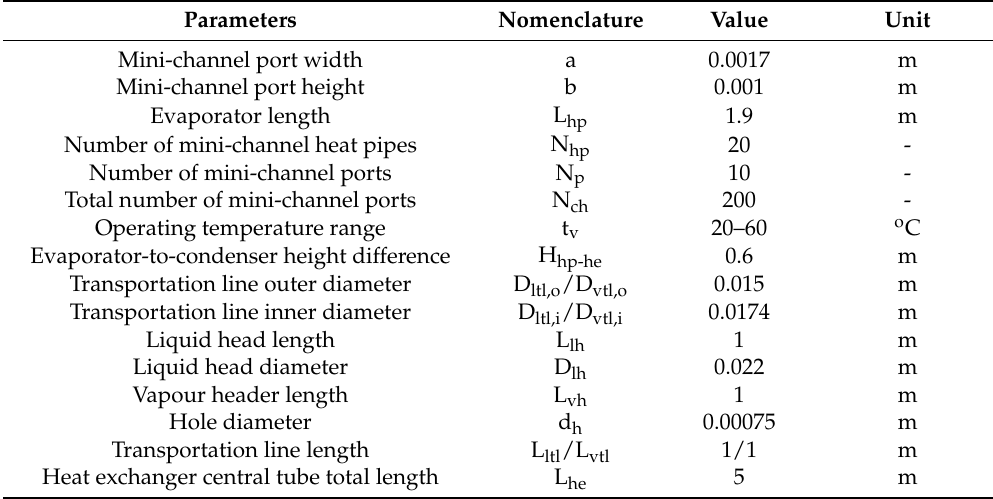
Table 1. Design parameters of the LHP operation and heat